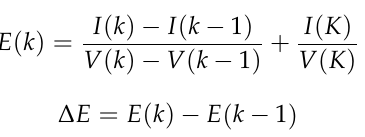
Figure 9. Flowchart of the hybrid technique FL-INC.